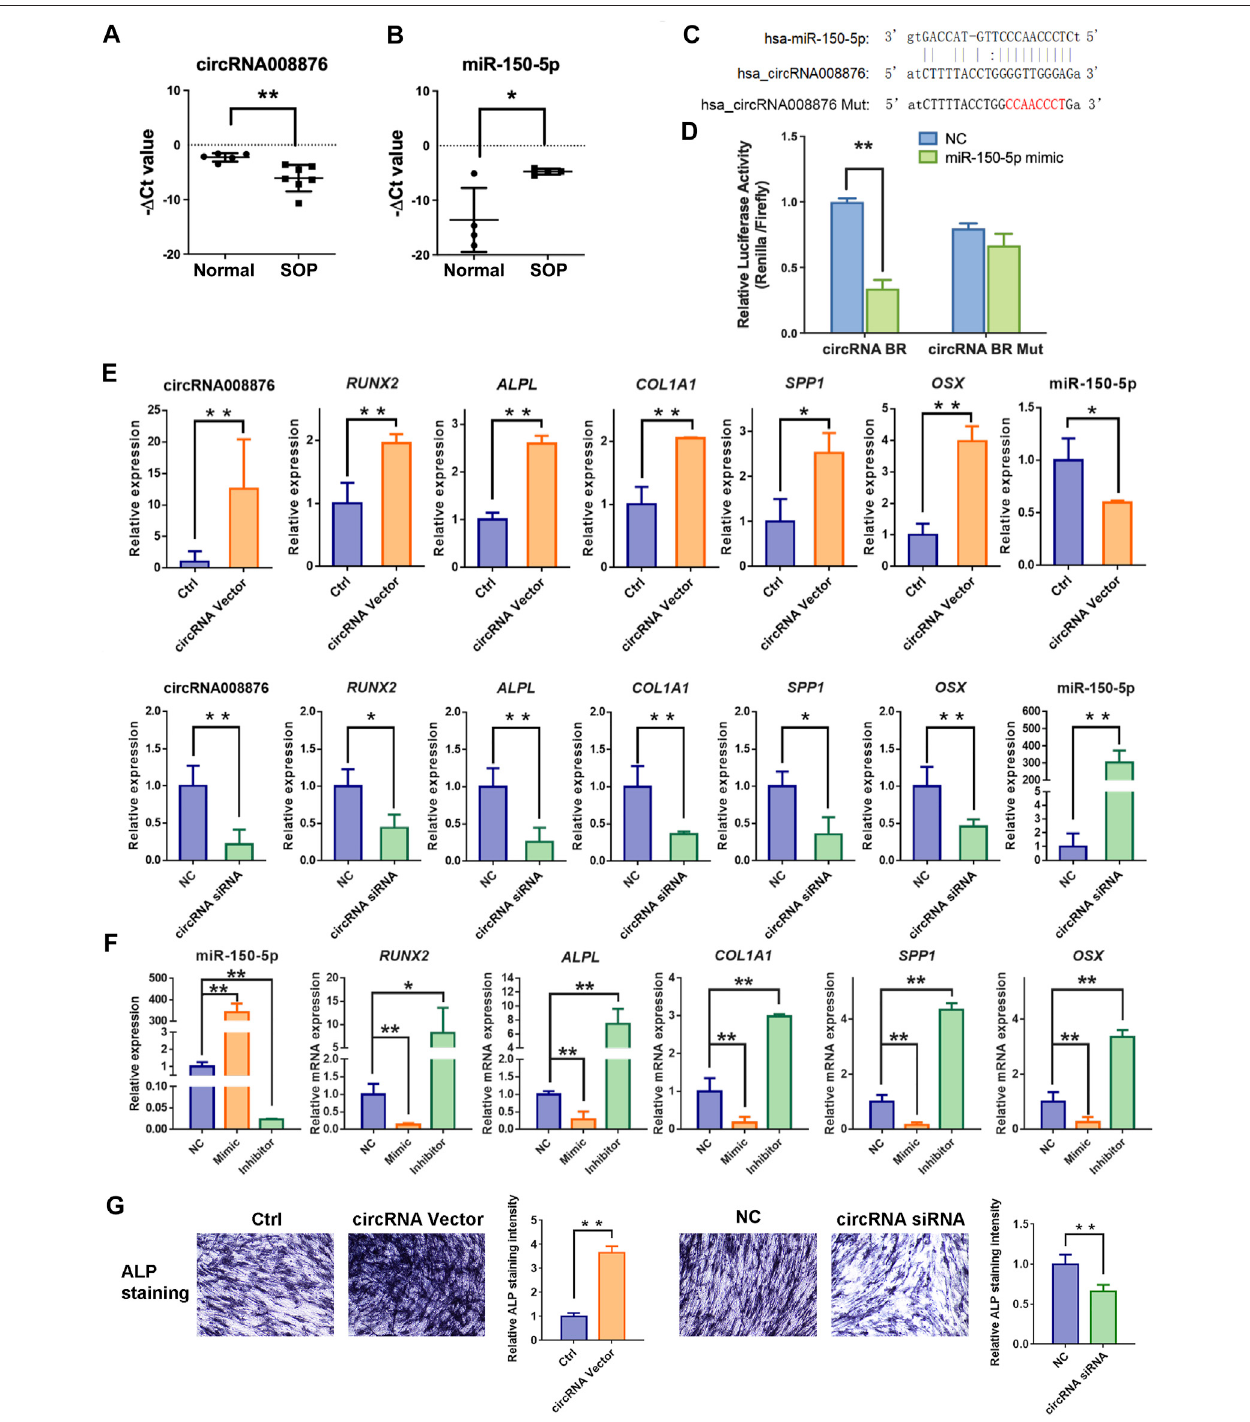
FIGURE 7 | circRNA008876/miR-150-5p regulate osteogenesis of hBMSCs. (A – B) Real-time PCR analysis of circRNA008876 (A) and miR-150-5p (B) expression of hBMSCs from SOP patients or the control group. GAPDH and U6 expression were used as an internal control for circRNA008876 and miR-150-5p, respectively. (C) Schematic representation of the wild-type and mutant binding sites of circRNA008876 targeting miR-150-5p. (D) HEK293T cells were transfected withpsiCHECK ™ -2VectorcontainingafragmentofcircRNA008876bindingsitesformiR-150-5p,orthecorrespondingmutantconstructs.TheeffectofmiR- 150-5p mimics on the corresponding vector luciferase activity was tested. (E) hBMSCs were transfected with circRNA008876 overexpressing vector or silencing siRNA. Expression of circRNA008876, miR-150-5p and osteogenesis genes including RUNX2, ALPL, COL1a1 , SPP1 and OSX were tested by qPCR 3 days after transfection. (F) hBMSCs were transfected with miR-150-5p mimic or inhibitor. Expression of miR-150-5p and osteogenesis genes were tested by qPCR 3 days after transfection. (G) Alkaline phosphatase (ALP) staining on Day 7 of hBMSCs transfected with circRNA008876 overexpressing vector or silencing siRNA. Images were captured under microscope with 100X enlargement. Relative ALP staining intensity were analyzed by ImageJ. Error bars, SEM (n (cid:1) 3). * p < 0.05, ** p < 0.01.